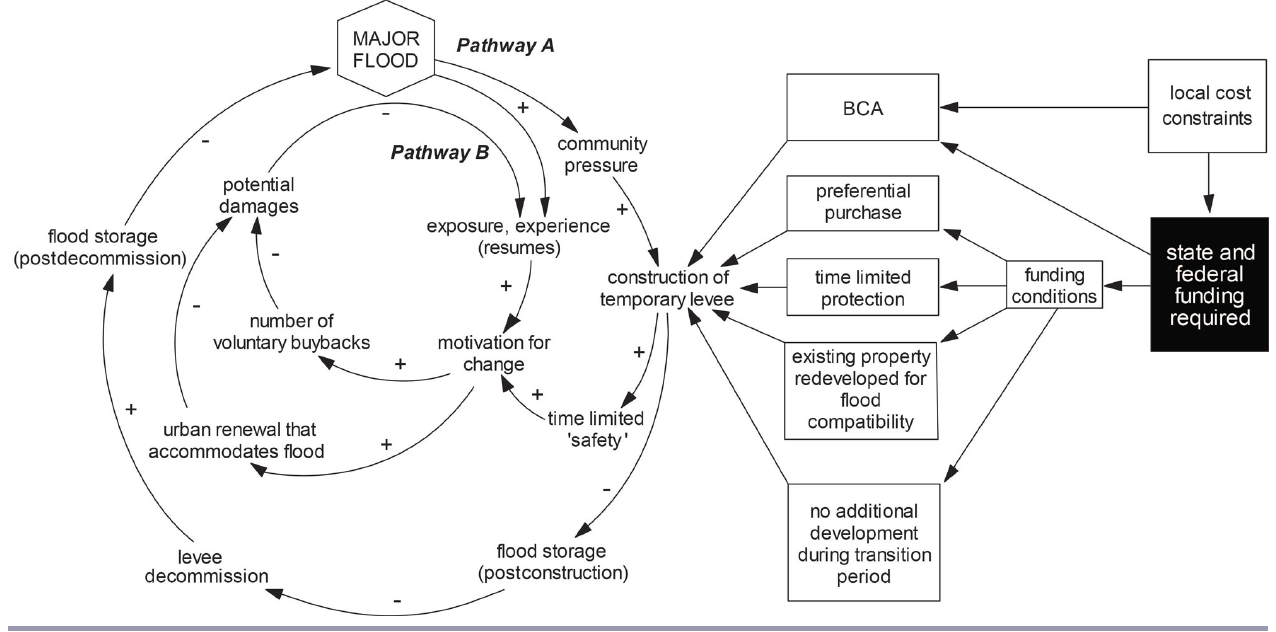
Fig. 7 . Changing feedbacks. Altered system feedbacks may lead to transformational change and greater long-term resilience. External funding provides transitional protection (Pathway A), allowing communities both time and incentives to adjust voluntarily. Incentives such as inbuilt requirements for levee decommission remove the perception of permanent protection. Existing residents may remain. However, in return for temporary protection, governments may require that buildings be modified or apply preferential purchase agreements at (indexed) prelevee prices to implement land use change over the longer term. While retrofitting or rebuilding existing structures is encouraged, a temporary moratorium on additional development prevents perverse incentives for development intensification within levee-protected areas. By the time the levee is decommissioned (Pathway B), the high-risk area has undergone changes that enable better accommodation of flooding and reduced impacts. Ongoing exposure engenders flood experience and motivates continual